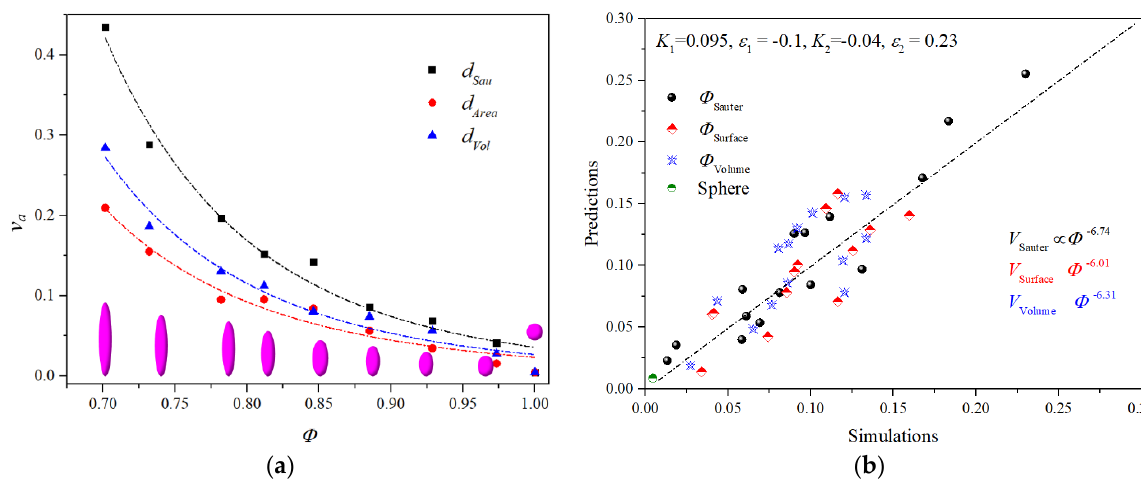
0.5 . Figure 12. Response of v 0.5 ⋅ f . d d d